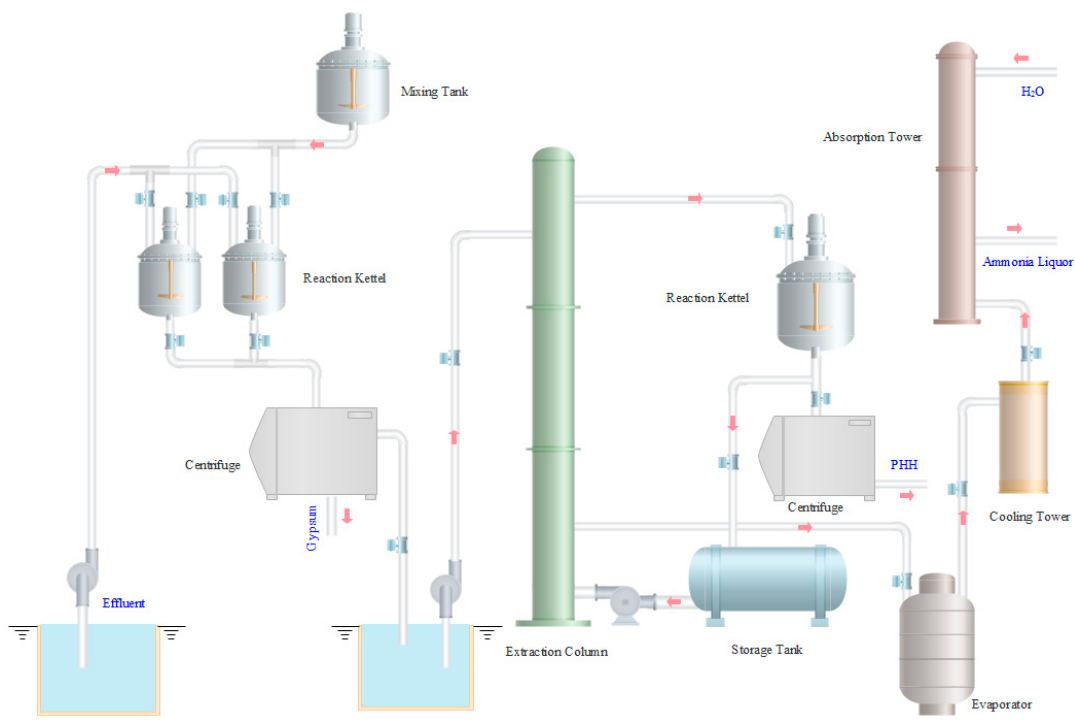
Figure 3. Effluent treatment devices used in pilot tests. Table 4. Results of the treatment of PHH production waste.